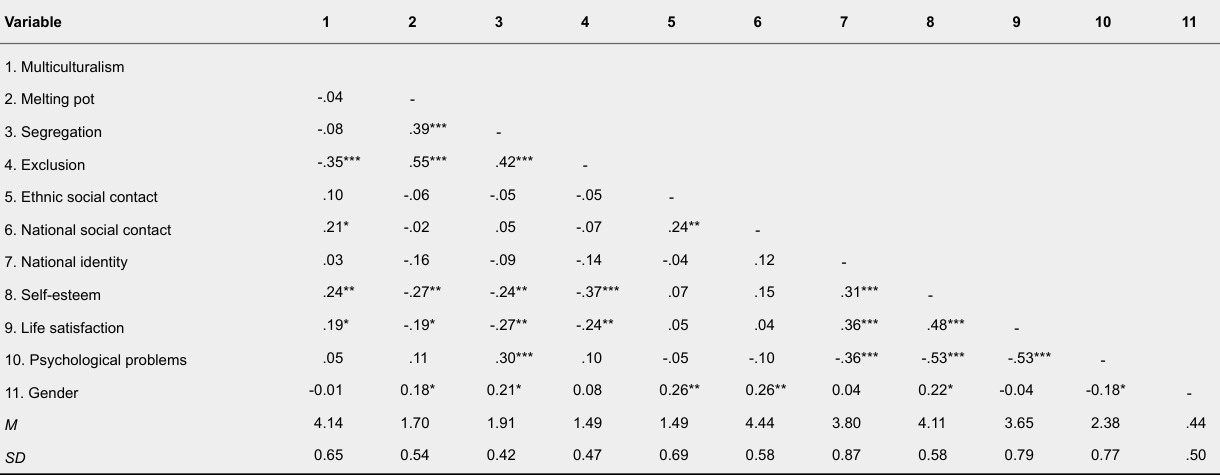
Means and Standard Deviations of, and Pearson Product-Moment Correlation Coefficients Between, Study Variables for Italian